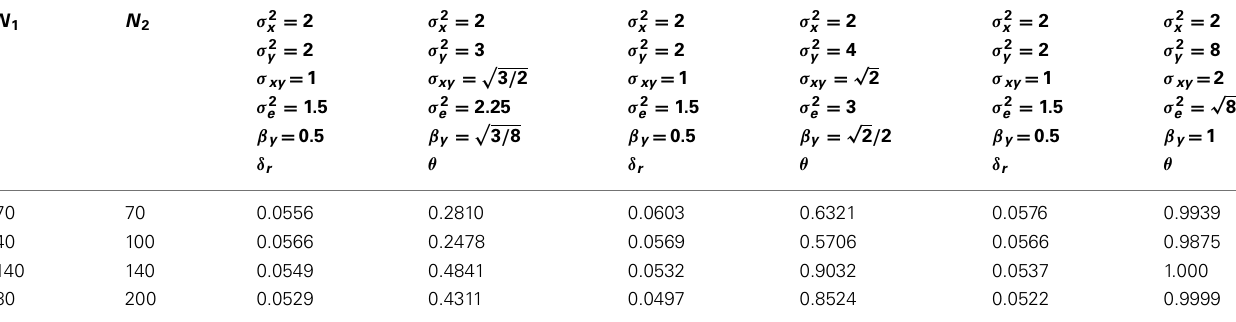
Table 2 | Power: moderated slopes and unmoderated correlations.